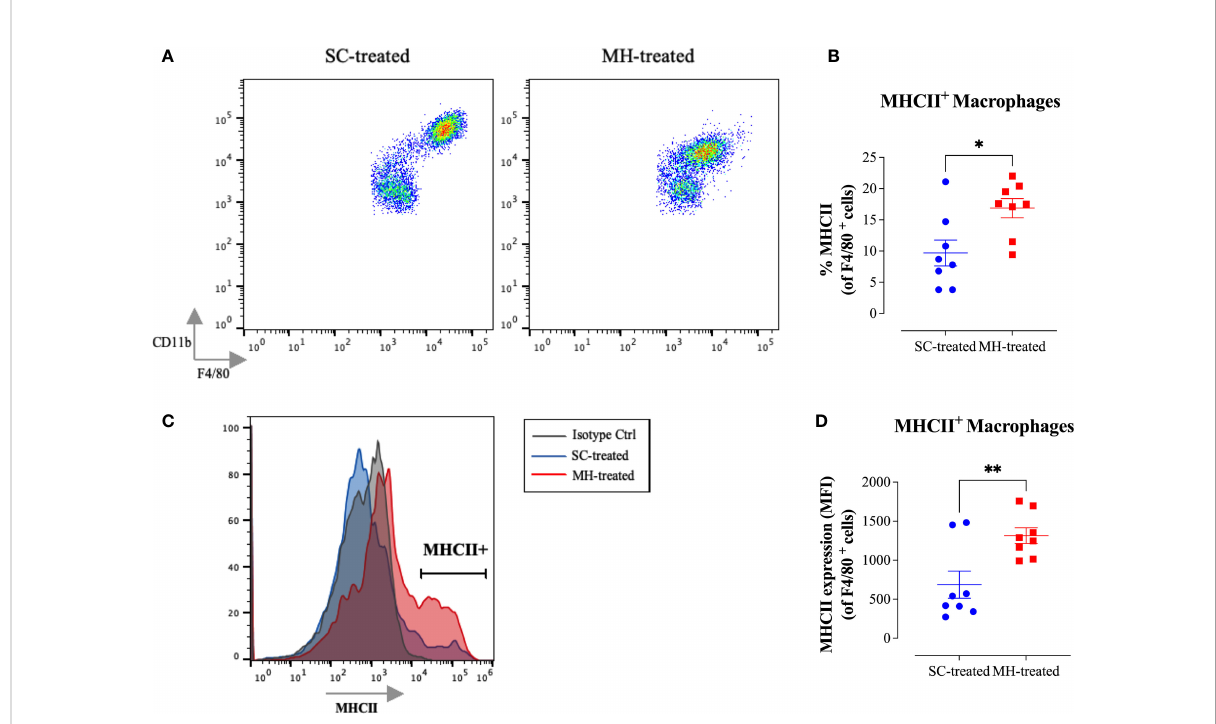
FIGURE 4 MH induces changes in the maturation of peritoneal myeloid cells in C57BL/6 mice. (A) Representative dot plots showing F4/80 + CD11b + cells (gated on macrophages) in SC-treated and MH-treated mice. (B) Representative overlay histograms showing MHC class II expression on F4/80 + macrophages of SC-treated and MH-treated mice. Grey histogram indicates staining with isotype matched control antibody. (C, D) Quanti fi cation of the percentage (C) and median fl uorescence intensity (D) of MHC class II + macrophages in SC-treated and MH-treated groups. Asterisks denote statistically signi fi cant differences between the MH-treated and SC-treated groups. The values for individual mice (mean ± SEM) are shown (SC-treated: n=8, MH-treated: n=8), pooled from 2 independent experiments. p values were calculated using the unpaired Student ’ s t-test (*p ≤ 0.05, **p ≤